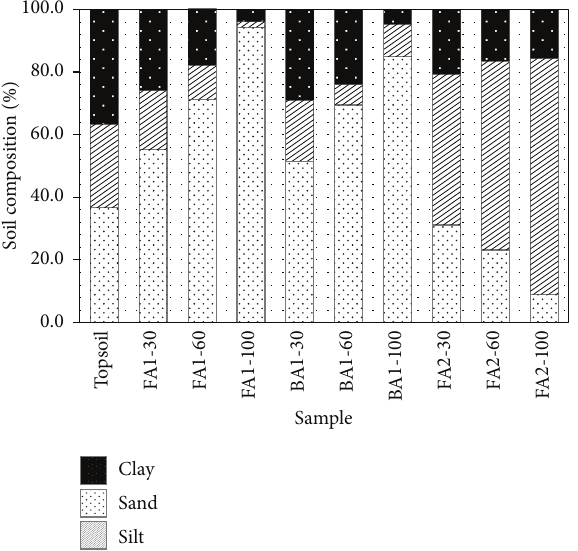
Table 3: The Atterberg limits of the simulated topsoil mixed with the coal ash at the mixing ratio of 0%, 30%, 60%, and 100%.